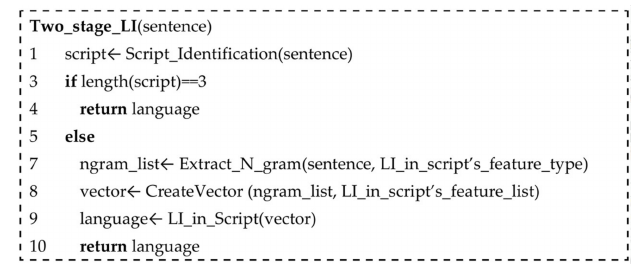
Figure 1. Pseudocode of two-stage language identification (LI).